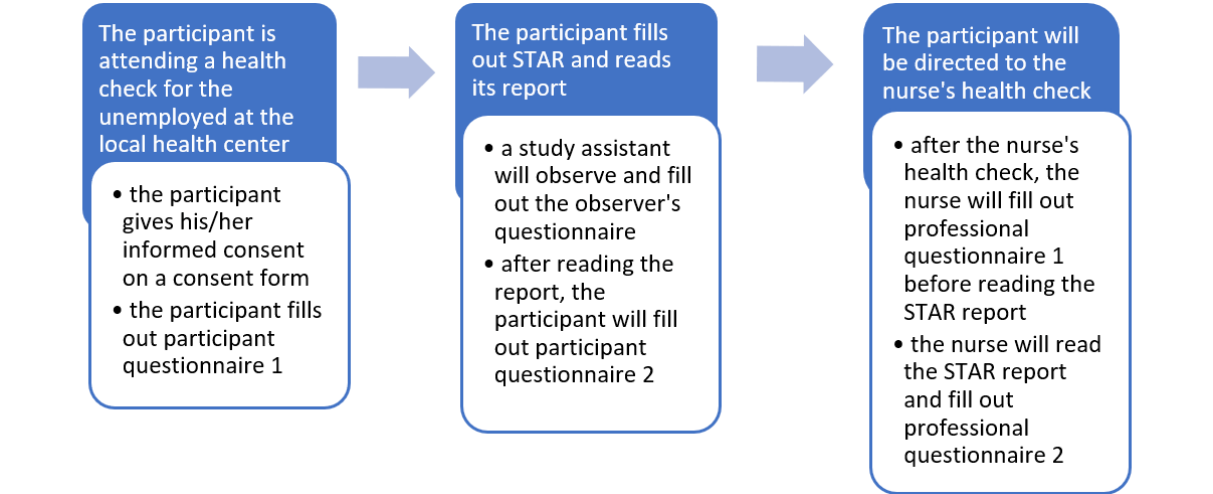
Figure 1. Flow of the study.